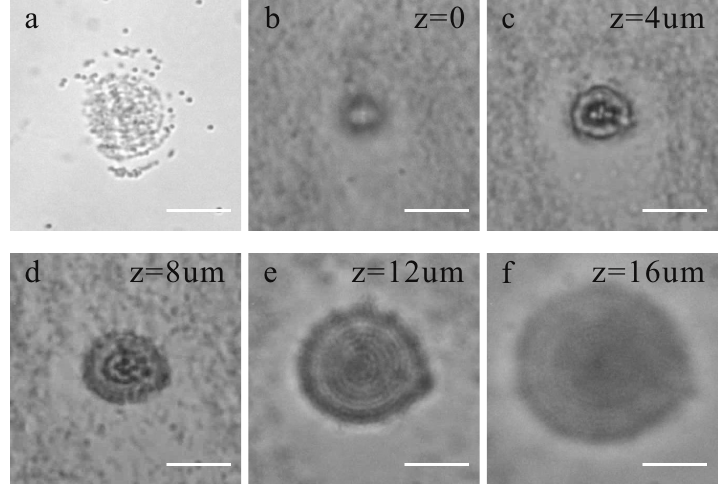
Figure 4. Images of the 0.5 µ m particles assembly formed by the diffraction pattern. ( a ) particle patterns at low concentration (4 × 10 9 cm − 3 ); ( b – f ) particle patterns at high concentration (10 11 cm − 3 ). The power is 820 mW; scale bar, 10 µ